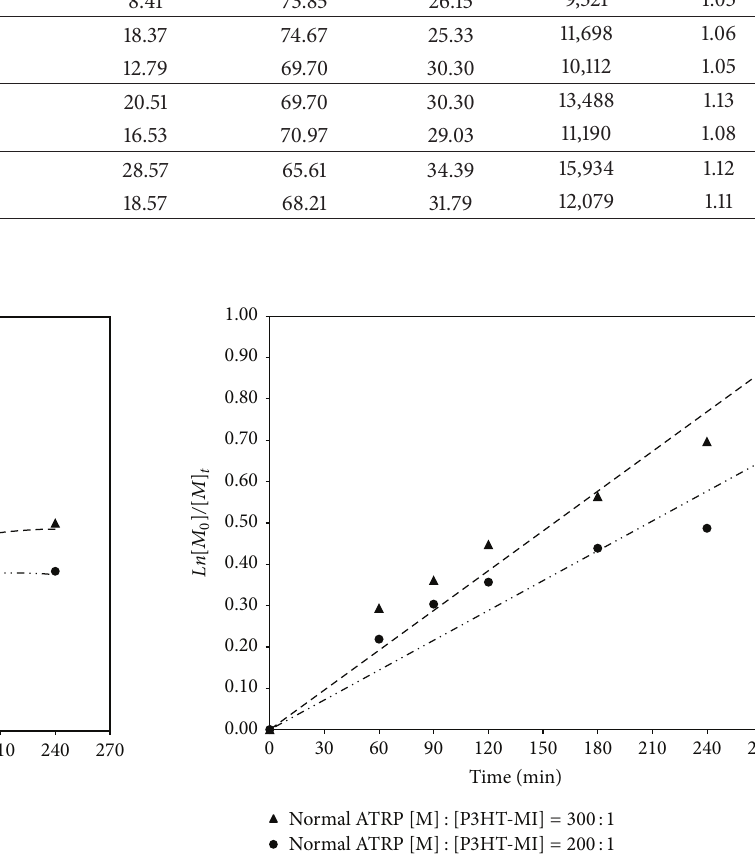
Figure 8: Kinetic plots of 𝐿𝑛[𝑀 0 ]/[𝑀] versus time for ATRP of styrene and CMS with the P3HT macroinitator (using different monomers/macroinitiator mole